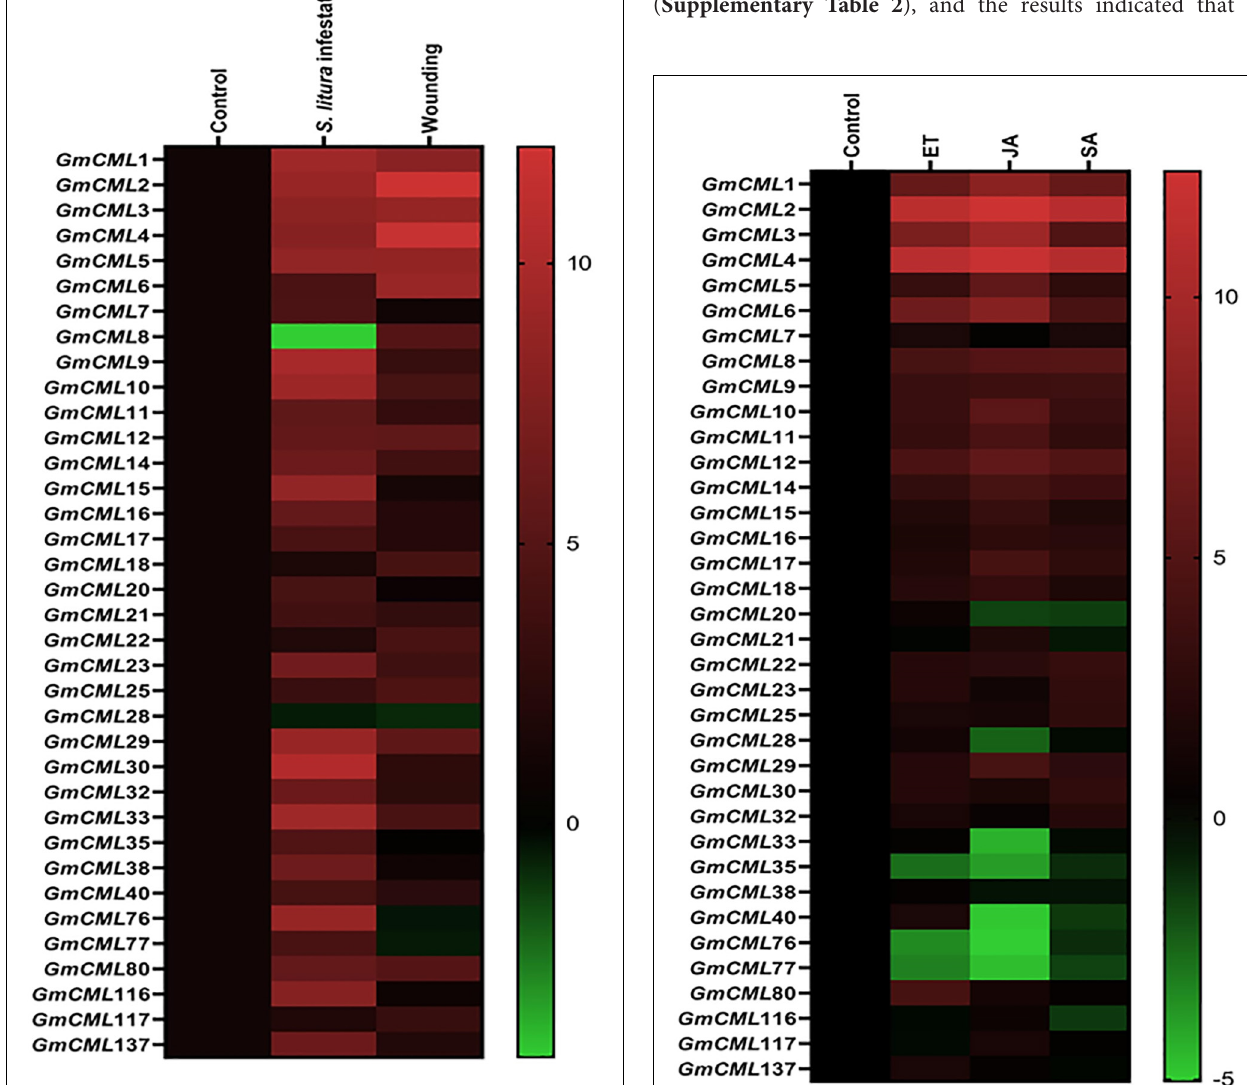
FIGURE 3 | Heat map showing expression profile of GmCML s on application of JA, SA, and ET. The expression profile of GmCML s on application of JA, SA, and ET is represented as a heat map, generated with the help of Graphpad Prism software using log 2 values of expression data obtained from qPCR. The qPCR data were analyzed utilizing the 2 − (cid:49)(cid:49) CT method and statistical analysis was performed using ANOVA and Tukey’s test ( P <